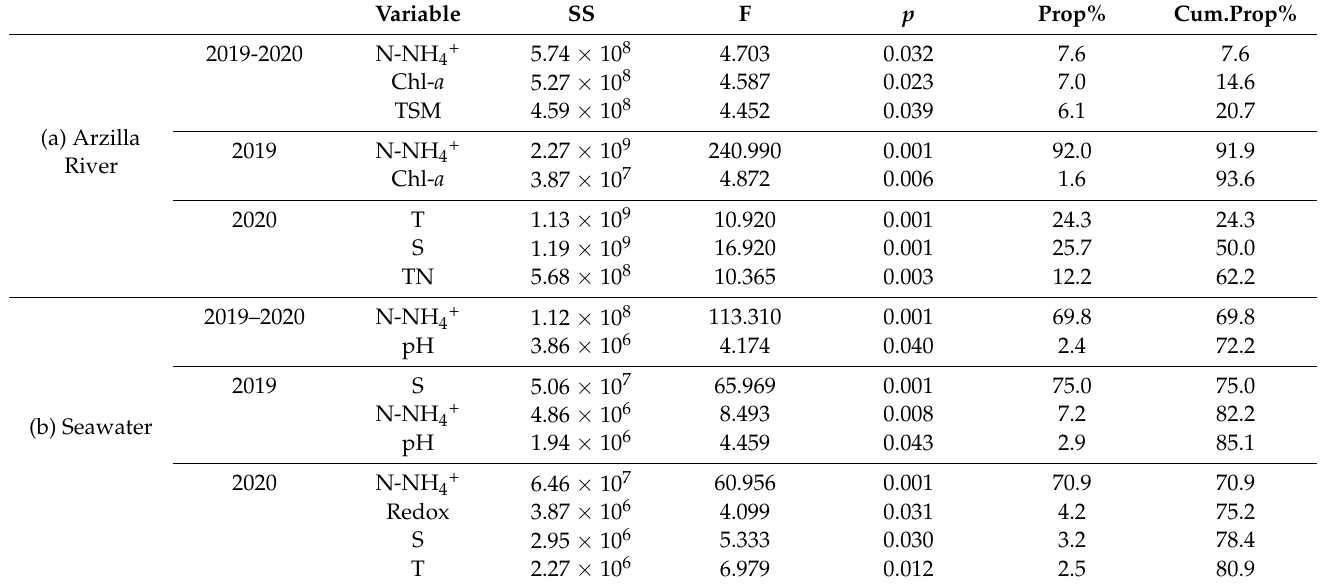
Table 2. Summary of DistLM statistical analysis carried out to test for relationships between the abundance of E. coli and intestinal enterococci and chemical–physical variables in the Arzilla River (a) and in seawater (b) during all sampling periods (2019–2020) and each sampling year separately. Results of sequential tests. SS = mean square; F = F statistic; TSM = total suspended matter; T = temperature; S = salinity; TN = total nitrogen. Only significant relationships are shown. Variable SS F p Prop% Cum.Prop%